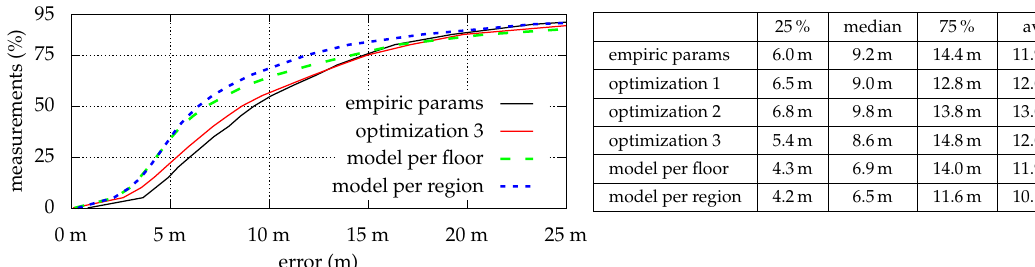
Figure 8. Cumulative error distribution for the error between a location estimation using Equation (14) (only Wi-Fi) and the corresponding ground truth depending on the signal strength prediction model, using each of the 3756 Wi-Fi measurements within the 13 walks. All models suffer from several (extremely) high errors that relate to bad Wi-Fi coverage e.g., within outdoor areas (see Figure 3). This negatively affects the resulting average and 75th percentile. The strategies optimization 1 and optimization 2 sometimes suffered from over-adaption, indicated by increased error values for the 25th